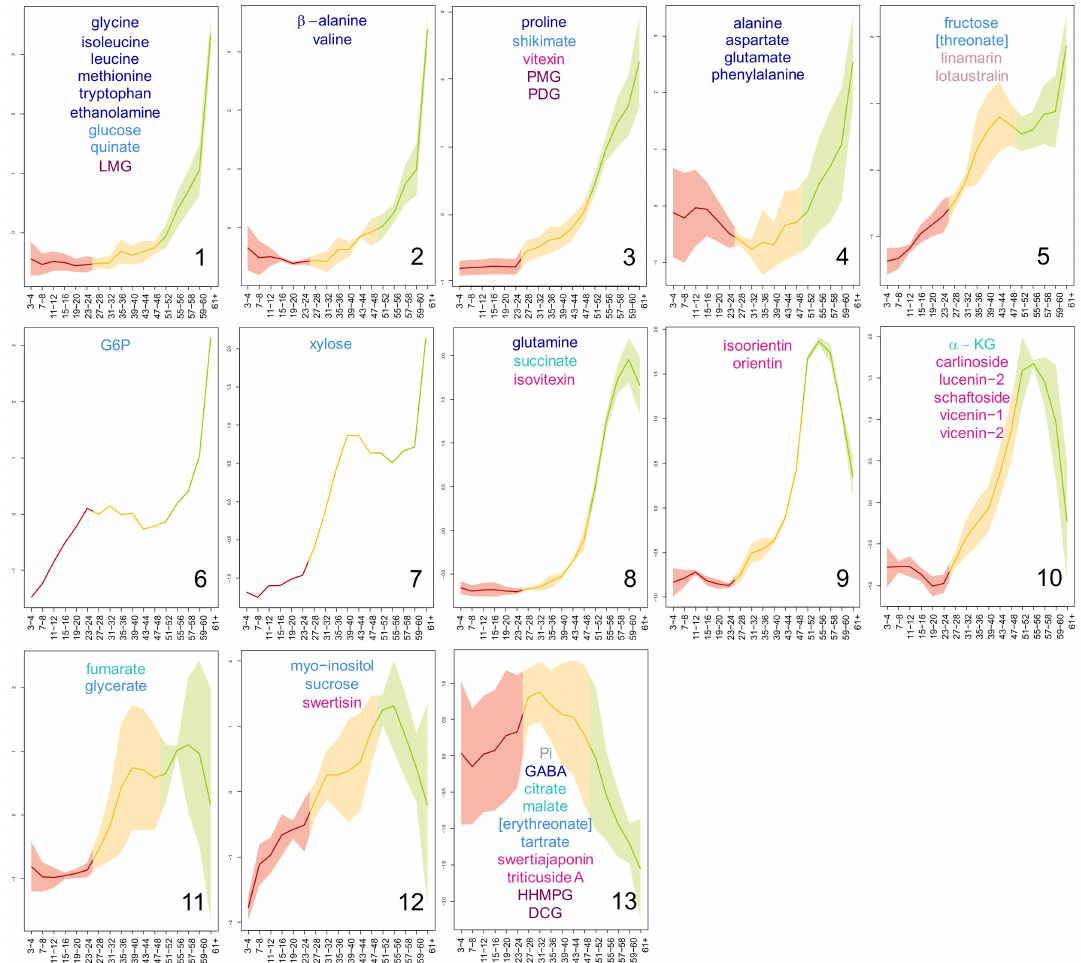
Figure 4. Metabolites grouped on the basis of their age-dependent content evolution in flax leaves. The classes (identified by the number within the circle) were defined using the Kohonen self-organising map (SOM) algorithm. Di ff erently coloured lines represent the content evolution in basal mature leaves (MLs) (red), intermediate transition leaves (TLs) (yellow), and apical young leaves (YLs) (green). The lighter coloured areas represent the standard deviation of the metabolites from the metabolic content of their respective class. The numbers below the x-axis identify the leaf samples. The metabolites are coloured with respect to their chemical identity: amino acids and derivatives (dark blue), carbohydrates and derivatives (light blue), tricarboxylic acids (teal), cyanogenic glycosides (pink), flavonoids (fuchsia), coniferyl alcohol derivatives (plum), and inorganic compounds (grey). For every leaf sample, n =